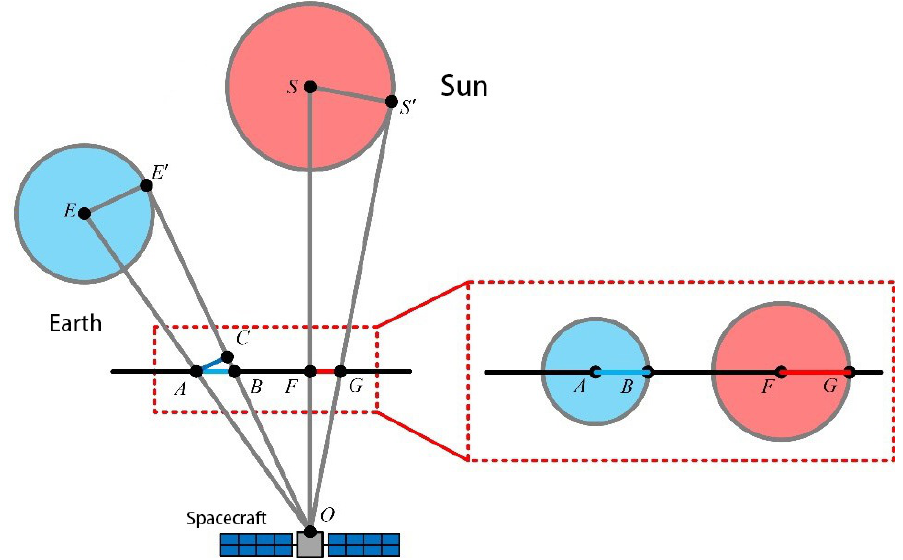
Figure 5. Measurement model of Earth